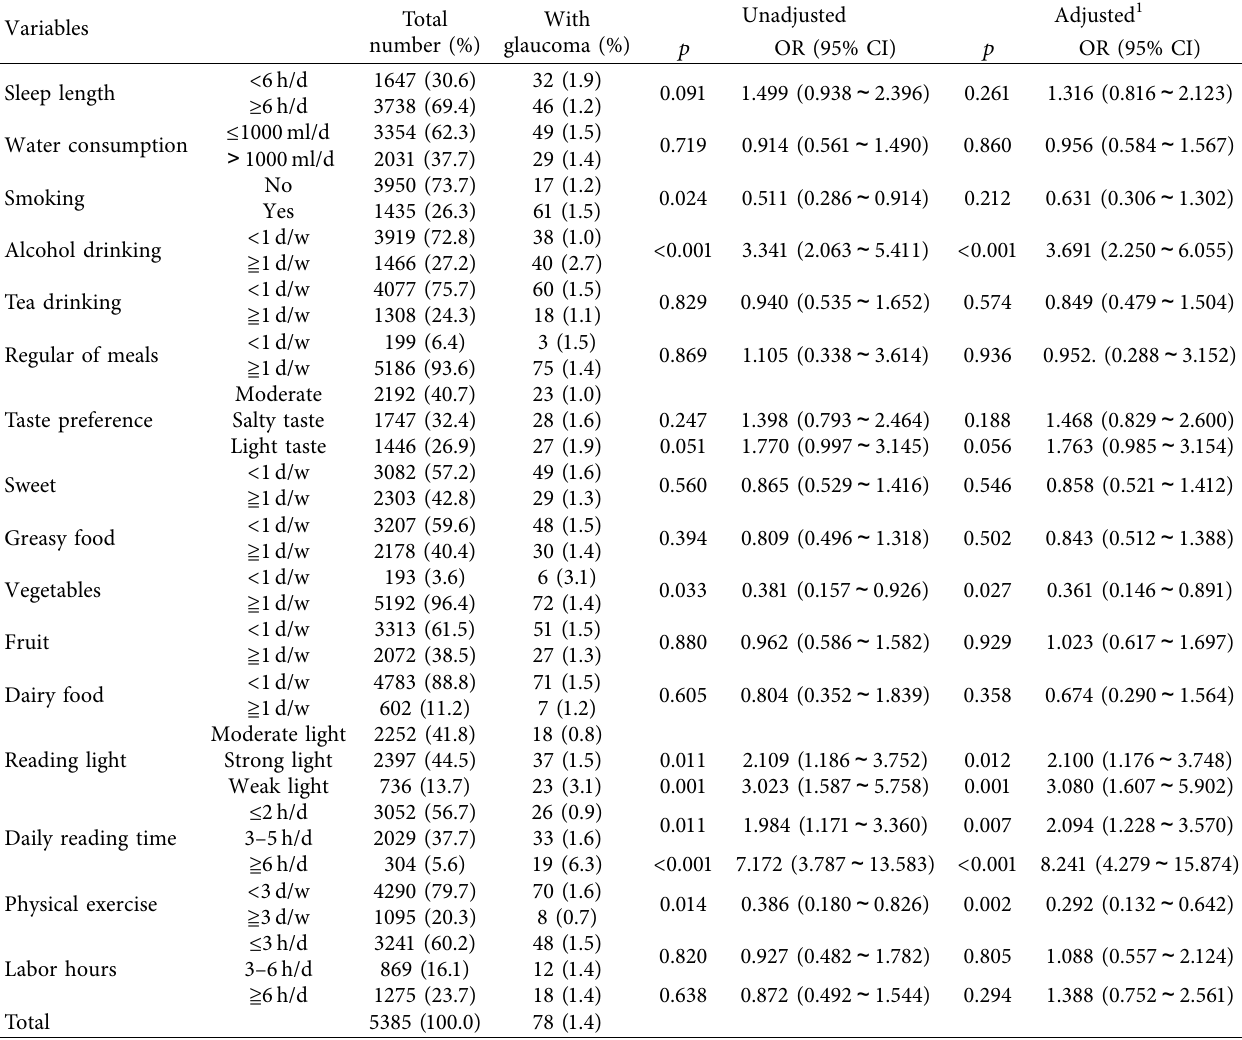
Table 2: Logistic regression analysis of factors related to the prevalence of glaucoma ( n � 5385) 1